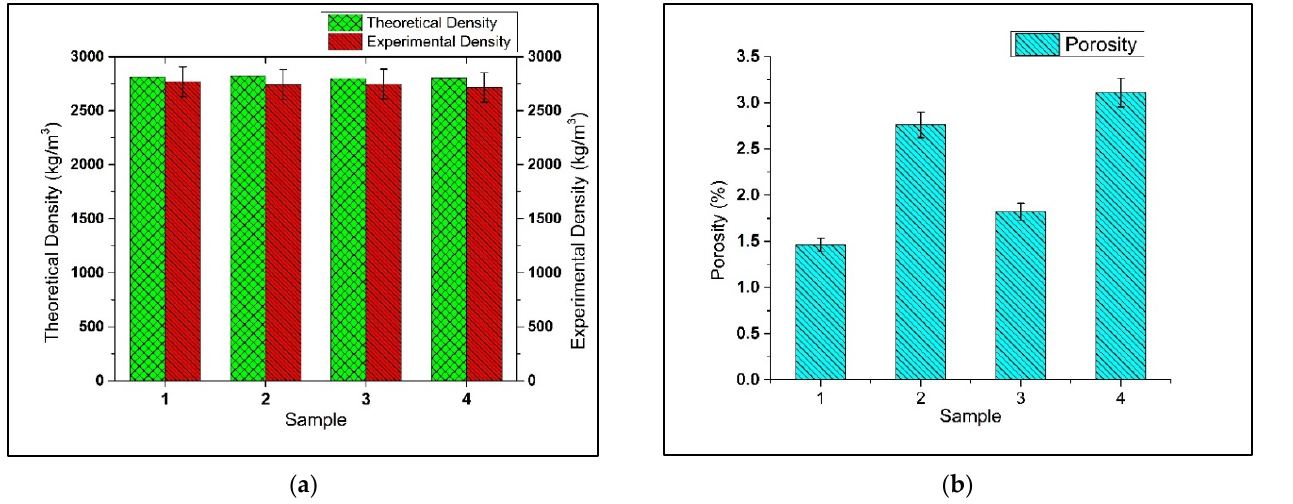
Figure 6. ( a ) Theoretical vs. experimental densities and ( b ) Porosity of: AA7075 (base alloy, sample 1), AA7075-5wt %SiC (MMC, sample 2), AA7075-5wt %SiC-3wt %RHA (s-HMMC, sample 3) and